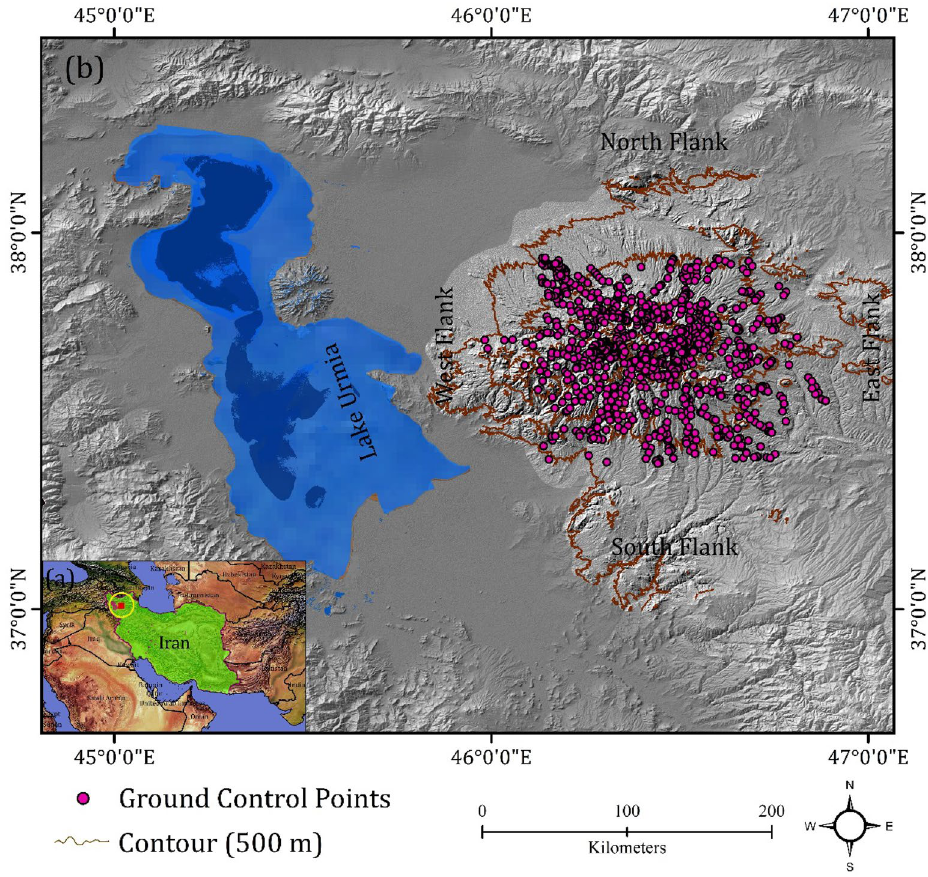
Figure 7. Location of study area ( a , b ) in the world and in Iran, and ( b ) in the north-west of Iran.